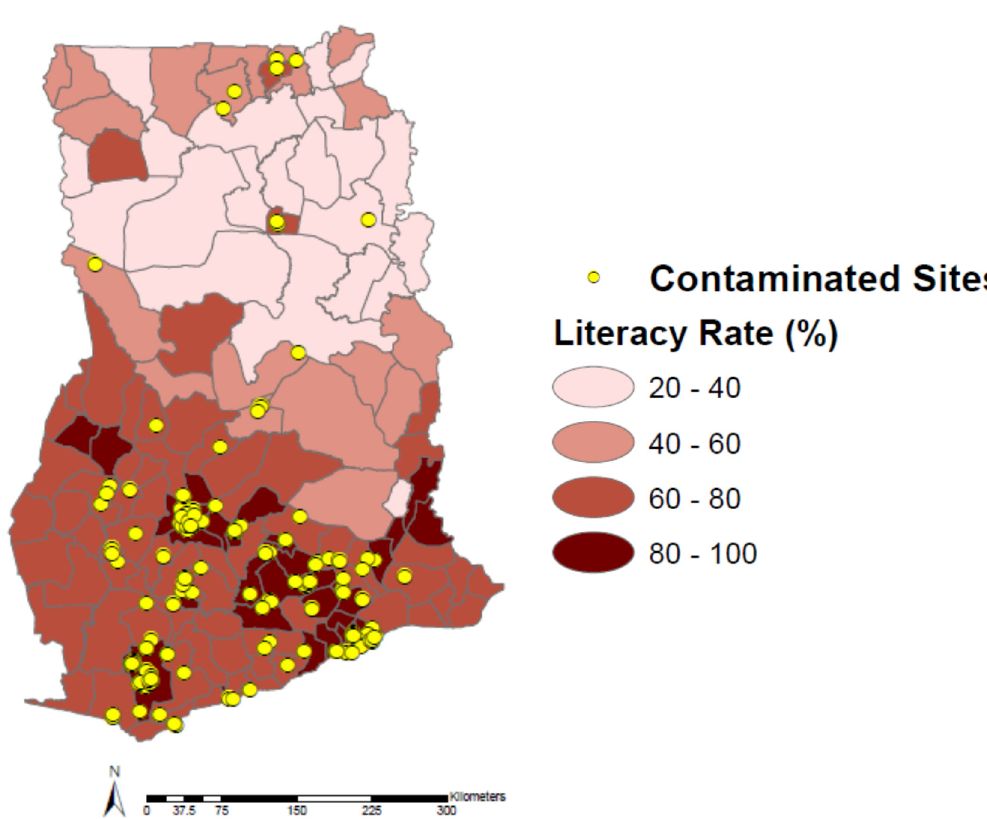
Figure 6. Literacy in Ghana by administrative district and contaminated